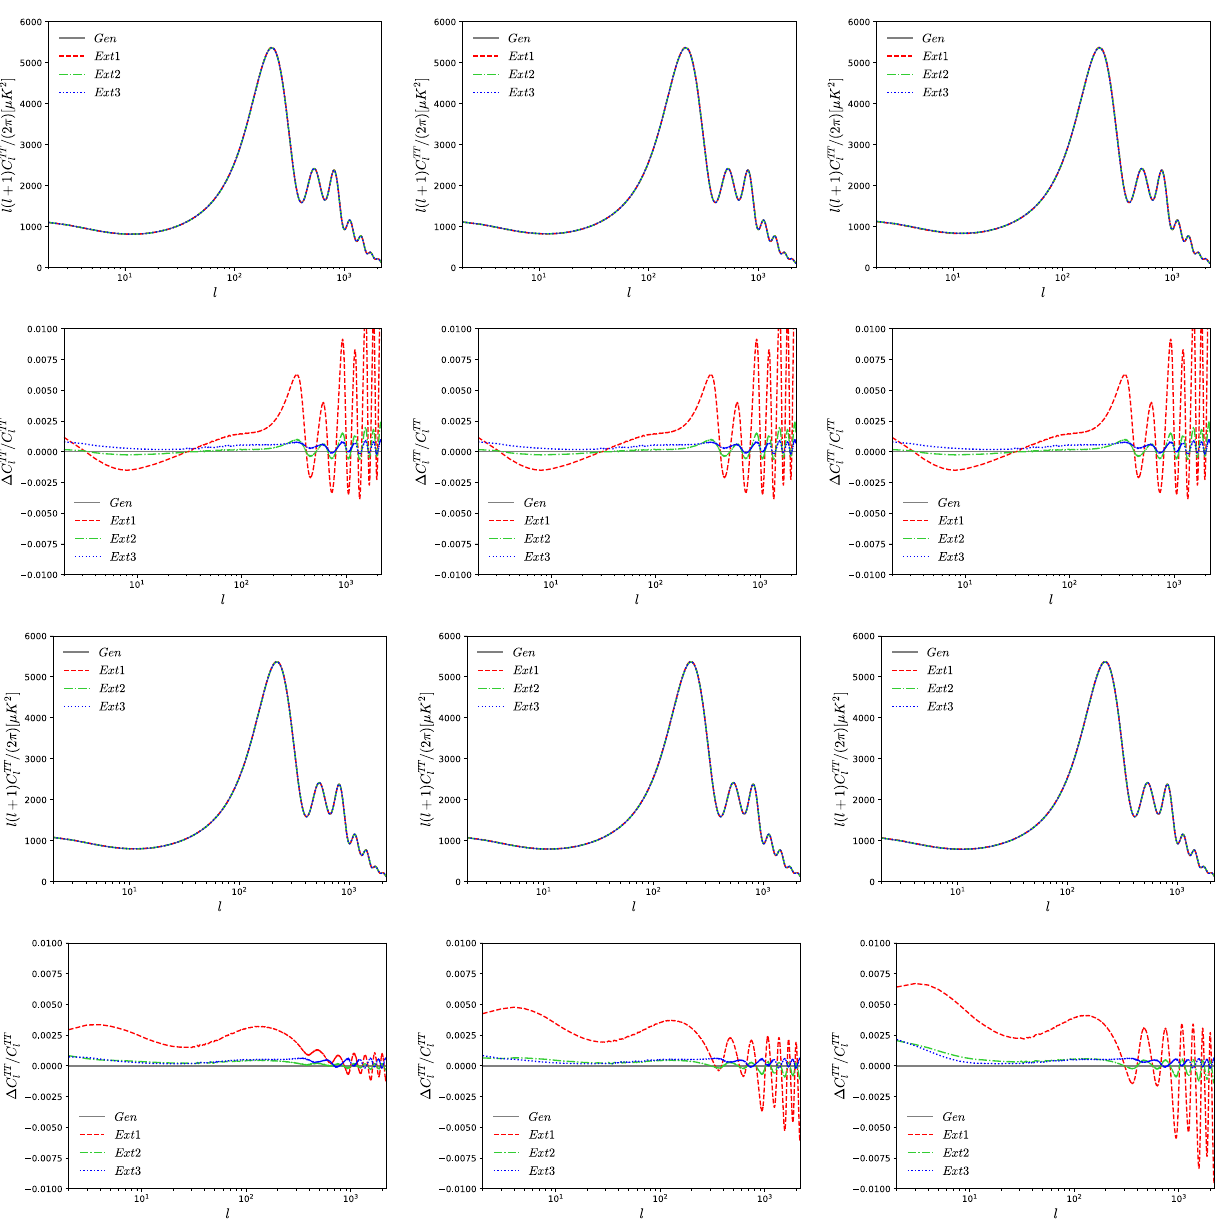
panels of this figure respectively stand for w a = 0 . 1 , 0 . 2 , and 0 . 3. Sim- ilarly, the plots in the third row (showing the cosmic microwave back- ground spectra) and last row (residual plots of the third row) stand for w < 0inwhichtheplotsfromlefttorightforboththeaboverows(third a and last rows) of this figure respectively stand for w a = − 0 . 1 , − 0 . 2 , and − 0 .